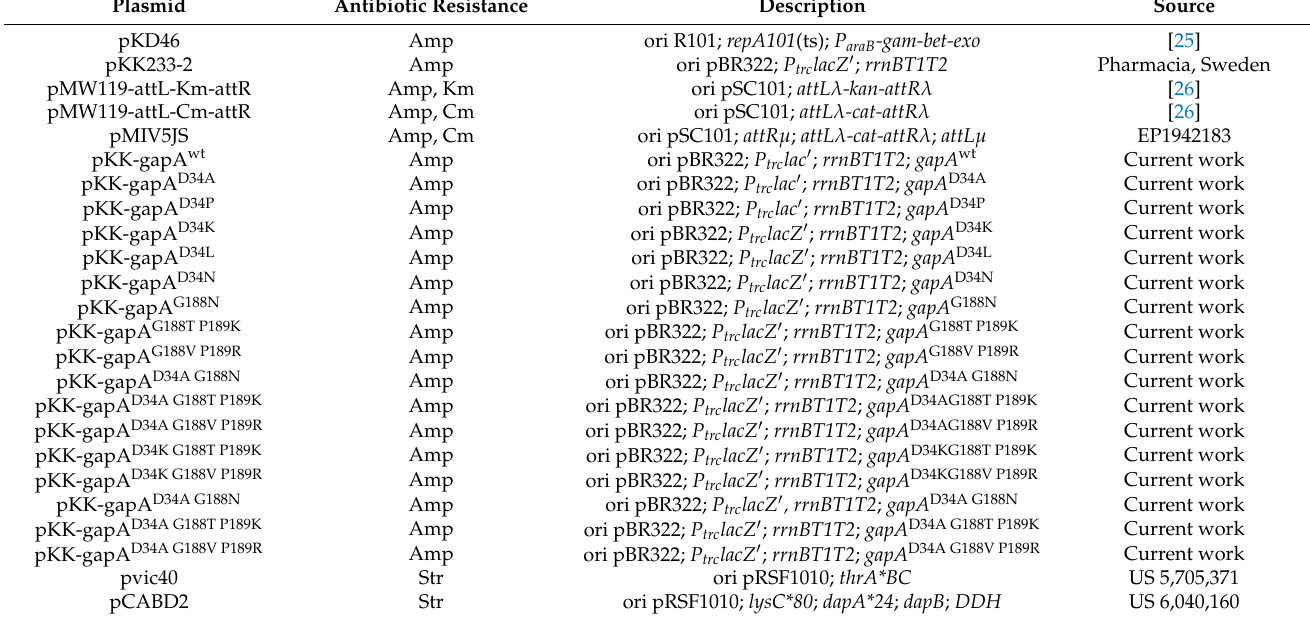
Table 2. Plasmids used in this